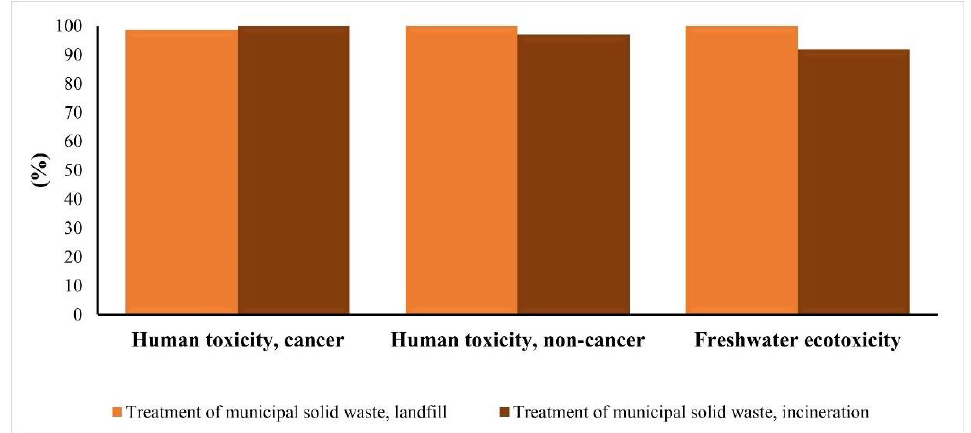
Figure 16. Relative environmental impacts of CD-5 for incineration and landfill disposal scenario, applying USEtox